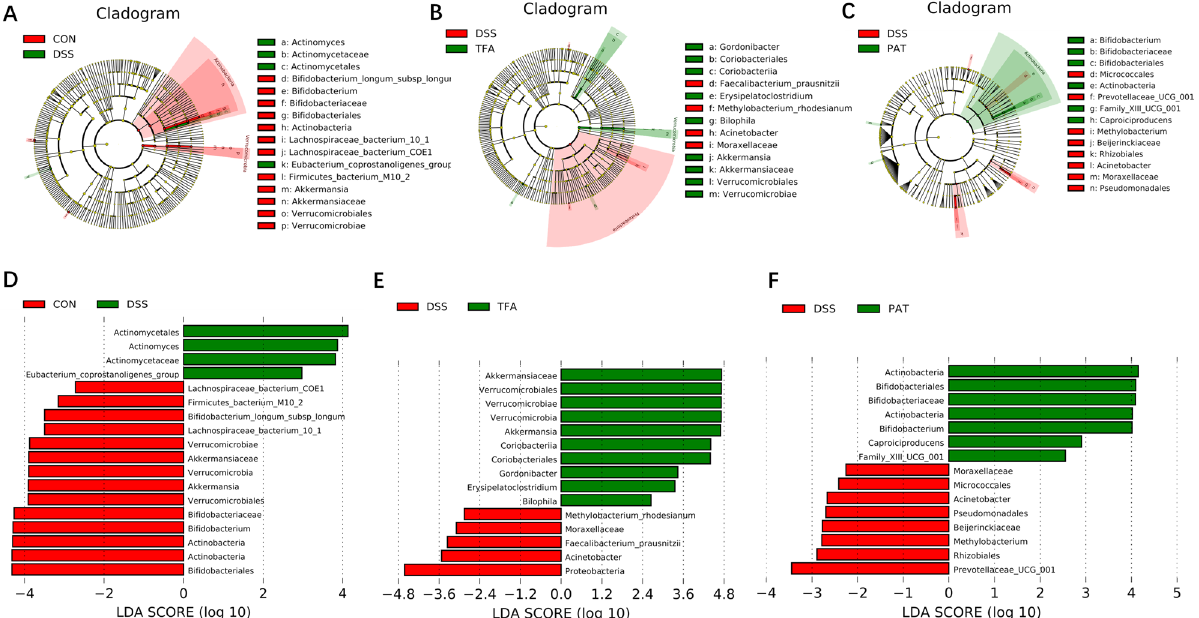
Figure 5. Characteristics of microbial community composition using LEfSe analysis. ( A ) LEfSe cladogram represents the taxa enriched in the DSS group (green) and control group (red). ( B ) Discriminative biomarkers with an LDA score > 2 between the DSS group (green) and control group (red). ( C ) LEfSe cladogram represents taxa enriched in the DSS group and TFA group. ( D ) Discriminative biomarkers with an LDA score > 2 between the DSS group (red) and TFA group (green). ( E ) LEfSe cladogram represents taxa enriched in the DSS group and PAT group. ( F ) Discriminative biomarkers with an LDA score > 2 between the DSS group (red) and PAT group (green), n =